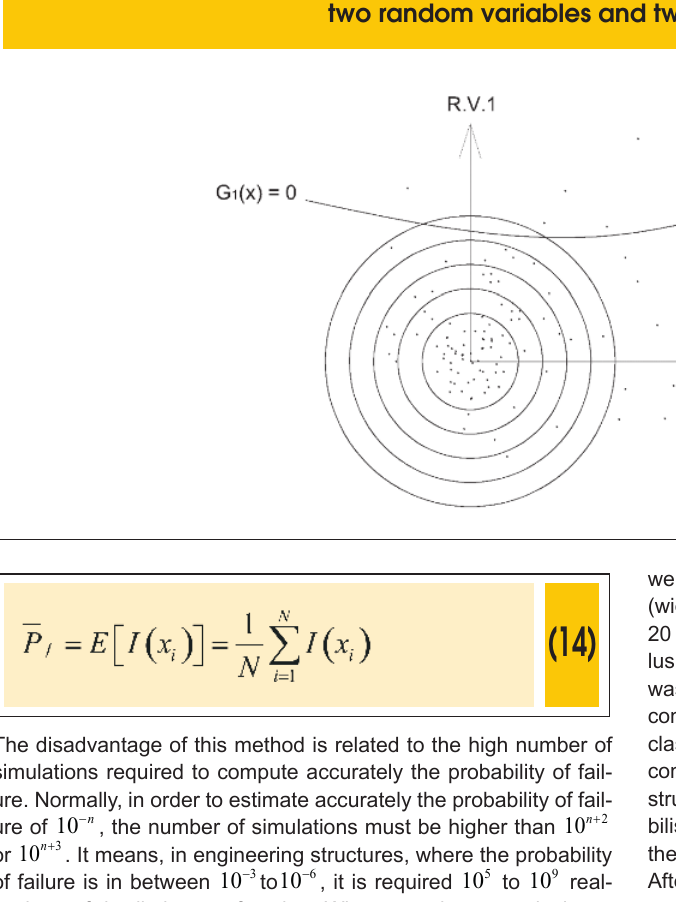
Figure 2 – Monte Carlo simulation method. General scheme considering two random variables and two limit state